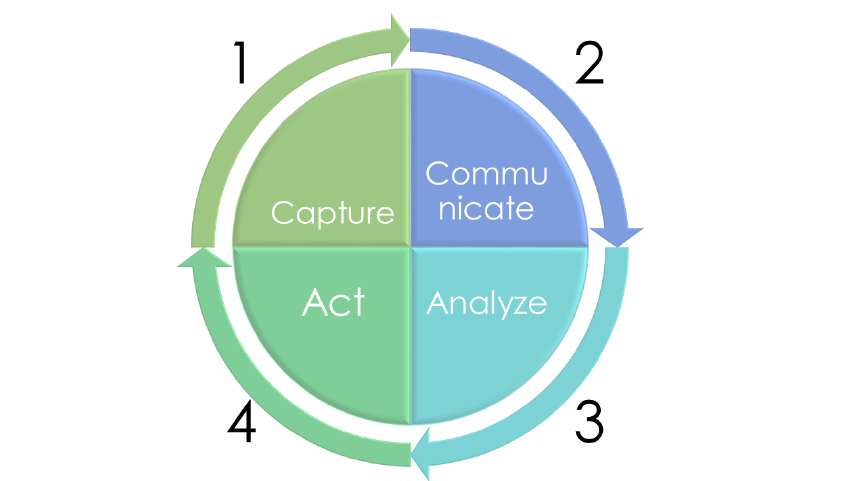
Figure 1. IoT data life cycle: Capture , Communicate , Analyse and Act .